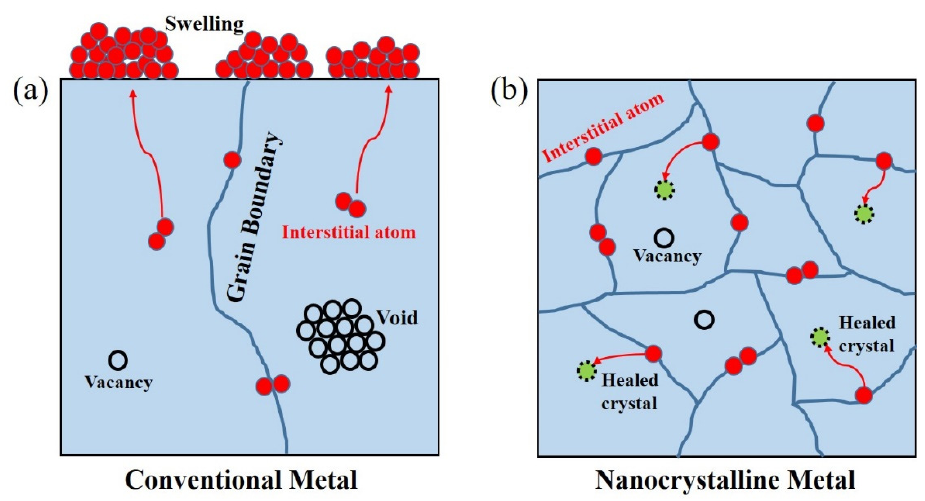
Figure 1. Schematic of the evolution of self ‐ interstitial atoms (SIAs) and vacancies caused by radia ‐ tion in ( a ) conventional material and ( b ) nanomaterial. in ( a ) conventional material and ( b )